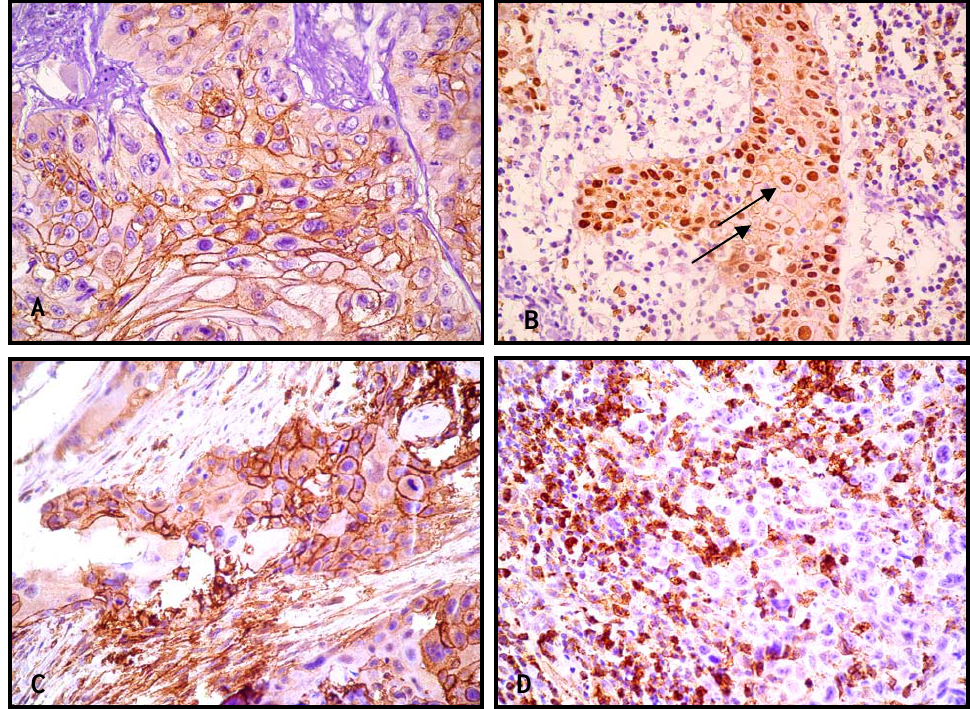
Figure 1. A) GLUT1 membrane immunostaining in oral squamous cell carcinoma, 400×; B) GLUT1 expression in oral squamous cell carcinoma. Note both GLUT1 expression: membrane and nucleus (arrows), 200×; C) GLUT3 membrane immunostaining in oral squamous cell carcinoma; D) No GLUT3 immunostaining. Note also GLUT3 expression in the inflammatory cells,